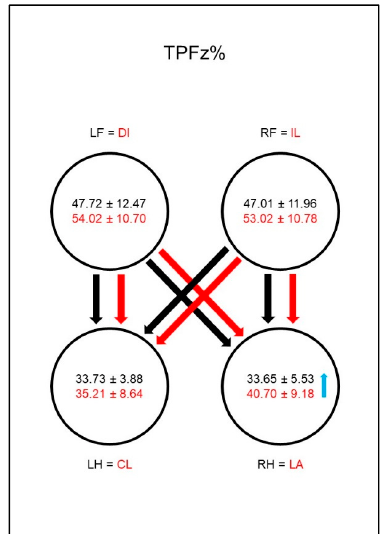
Figure 4. Time to PFz as a percentage of stance phase duration (TPFz%) in study group 1 and control group. For detailed explanation and abbreviations refer to Figure 2.